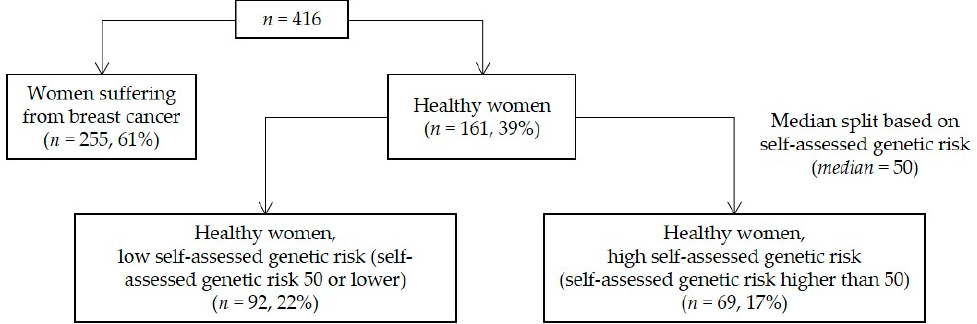
Figure 1. Overview of the sample and the three groups under investigation.